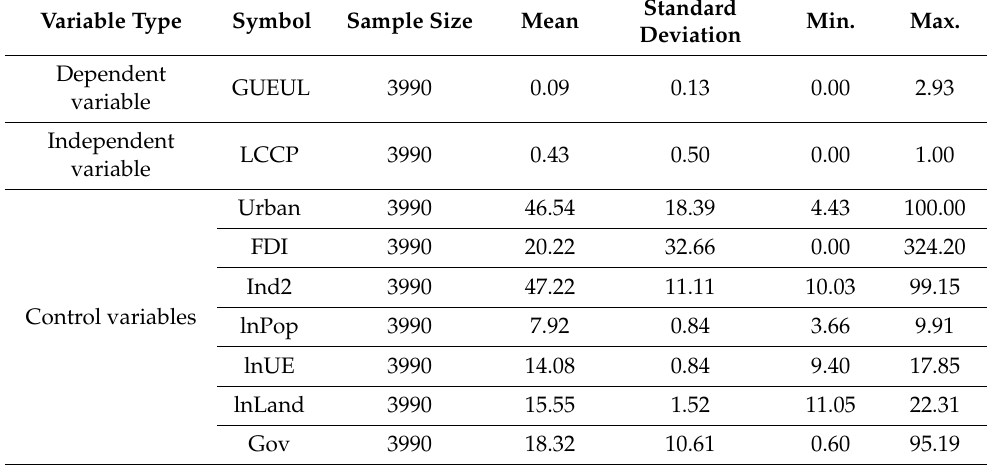
Table 2. Descriptive